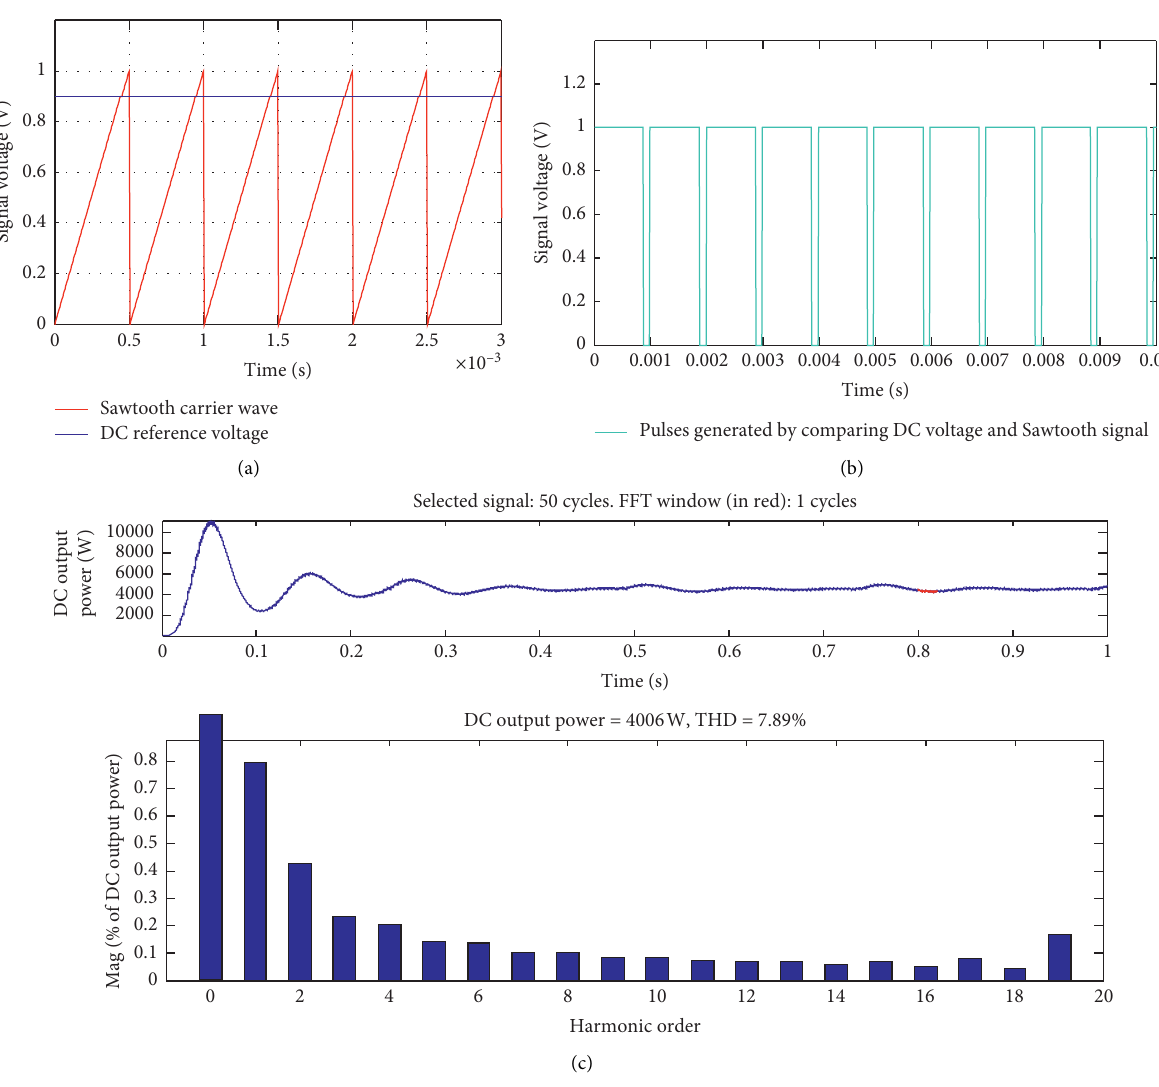
Figure 3: (a) DCVCSM. (b) Firing pulses of ZPCSMS. (c) Spectral analysis of the output power of boost DC-DC converter using